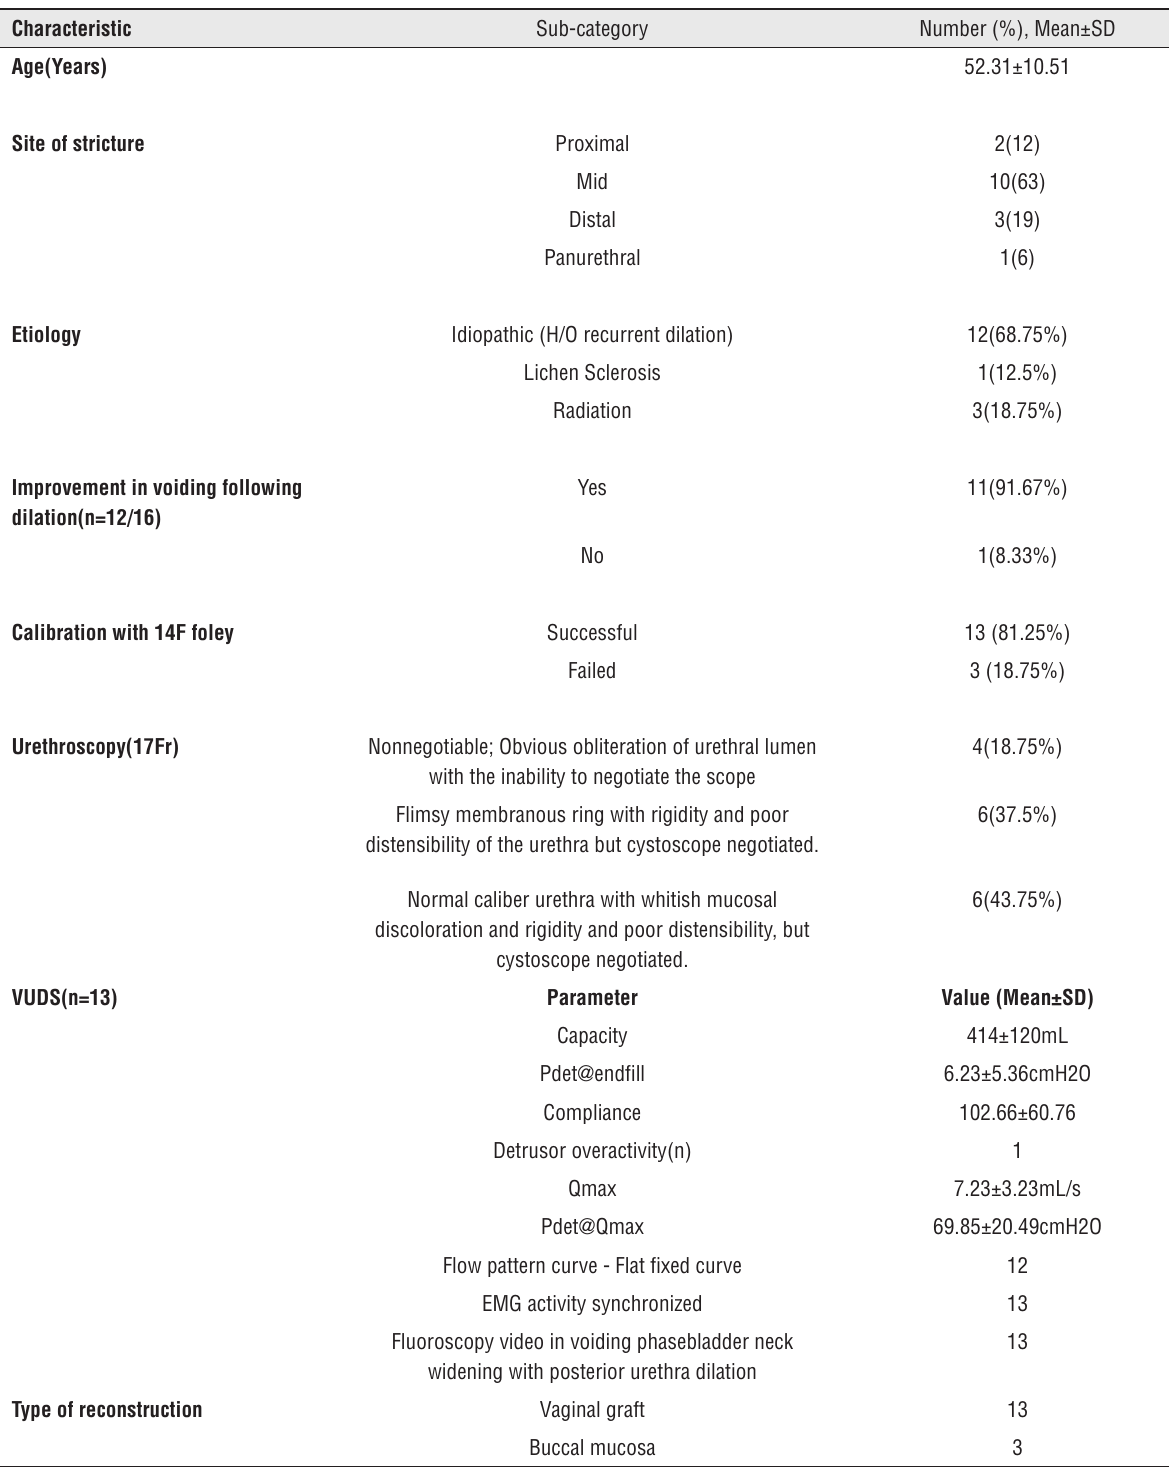
Table 2 - Clinical, VUDS, and urethroscopic characteristics of patients with Female urethral stricture.